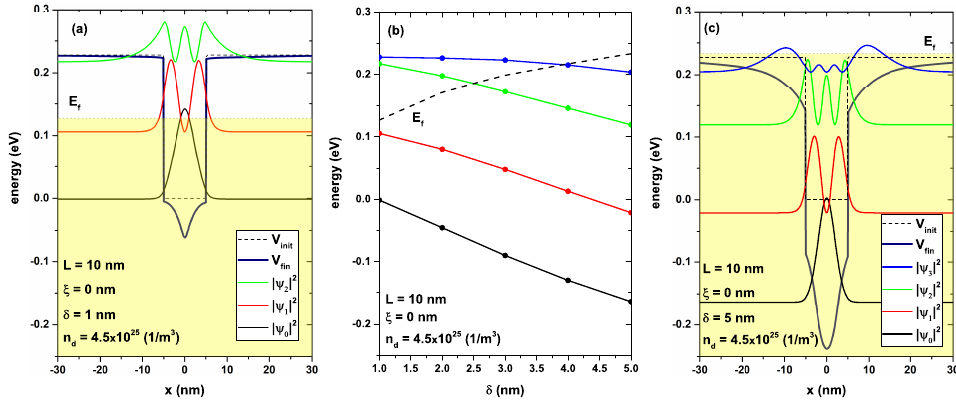
Figure 6. ( a , c ): Self-consistent potentials V ( x ) , with a solid line in navy color, and electron confine- ment potential V c ( x ) in black dashed line. Figure ( a ) corresponds to δ = 1nm and Figure ( c ) to δ = 5nm. For both figures, the parameters L = 10nm, ξ = 0, and n d = 4.5 × 10 25 (1/m 3 ) were set. In both figures, the probability densities of all confined states were included. The shaded region indicates the occupied states, and the maximum of this region corresponded to the energy Fermi level. Figure ( b ) represents the energy of the confined states according to the δ -parameter; the dashed line is the self-consistent Fermi level E f